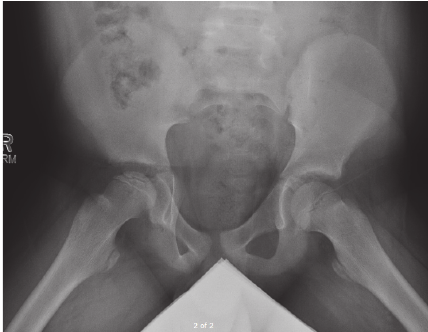
Figure 2: Frog leg lateral X-ray of bilateral hips again showing avas- cular changes with characteristic “crescent sign” of osteonecrosis to right femoral head.